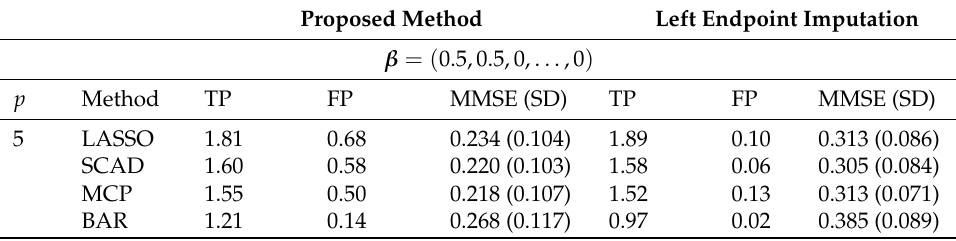
Table 6. Comparison of the proposed method to the left endpoint method. Proposed